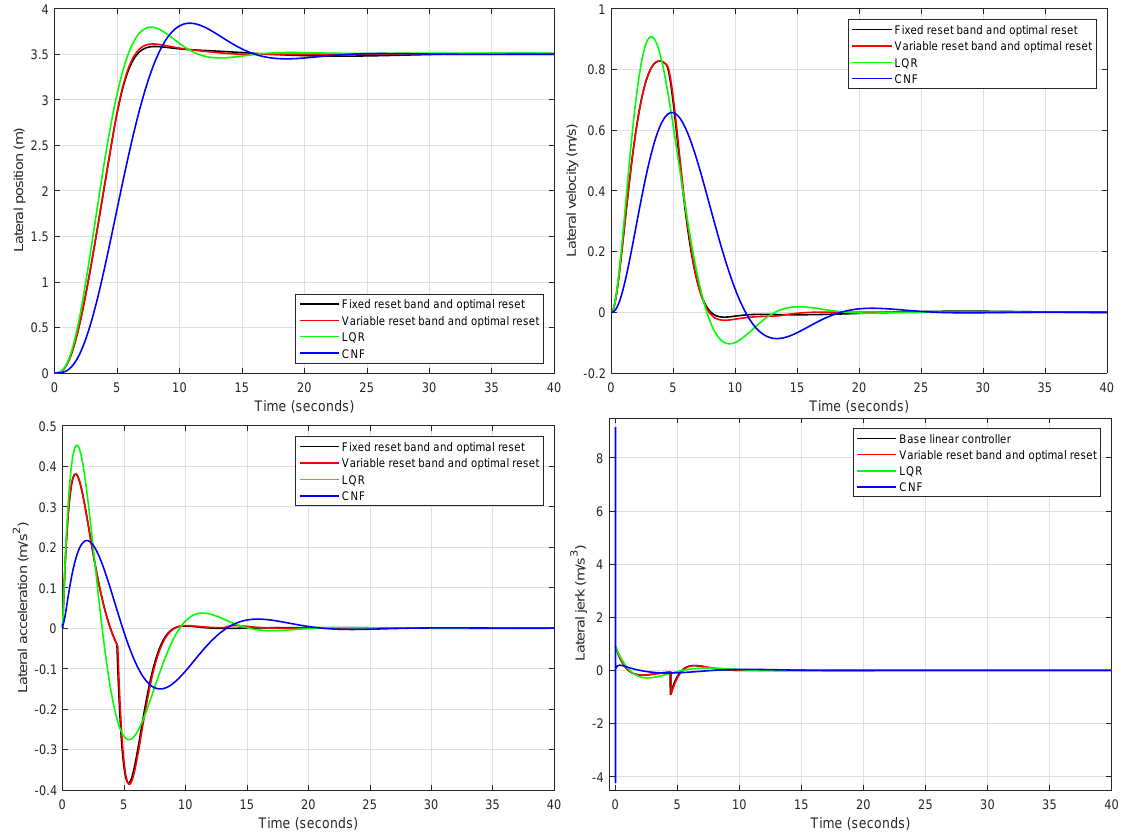
Figure 24. Position, velocity, acceleration and jerk for the following controllers: variable reset band and optimal reset, fixed reset band and optimal reset, linear-quadratic and